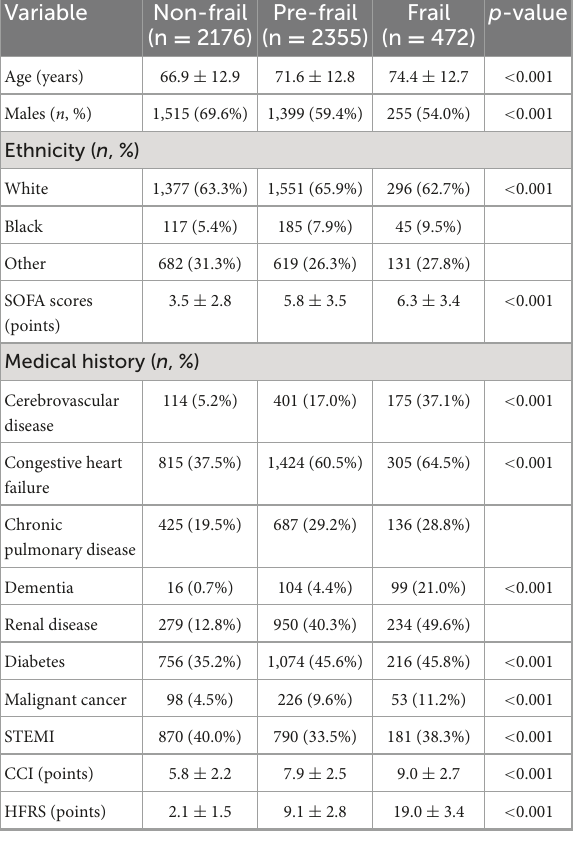
TABLE 1 Characteristics of included patients according to frailty status ( n =